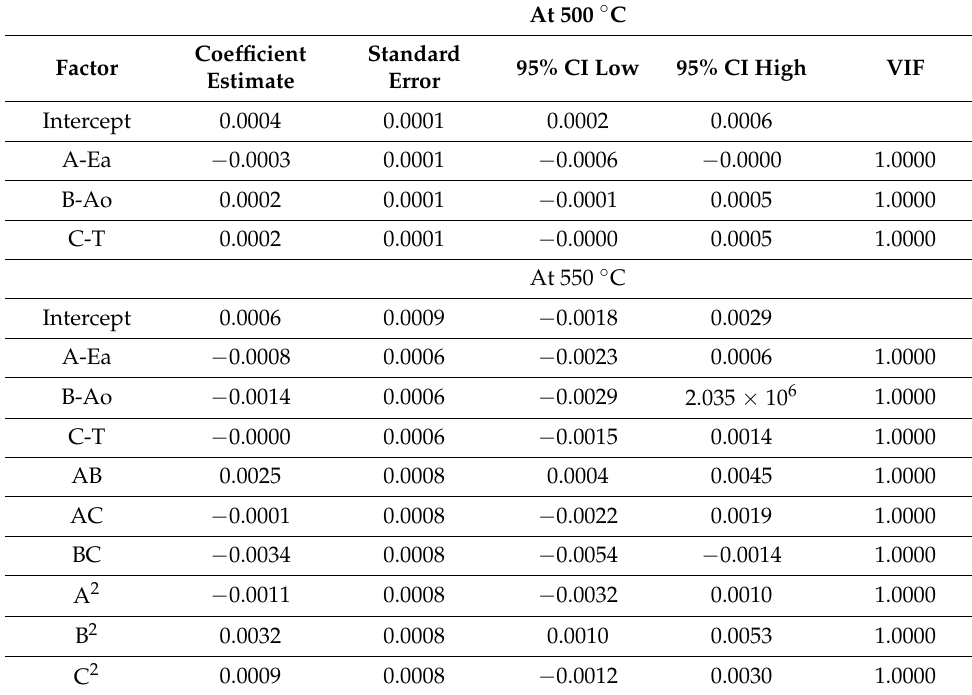
Table 4. Coefficients are calculated in the form of coded